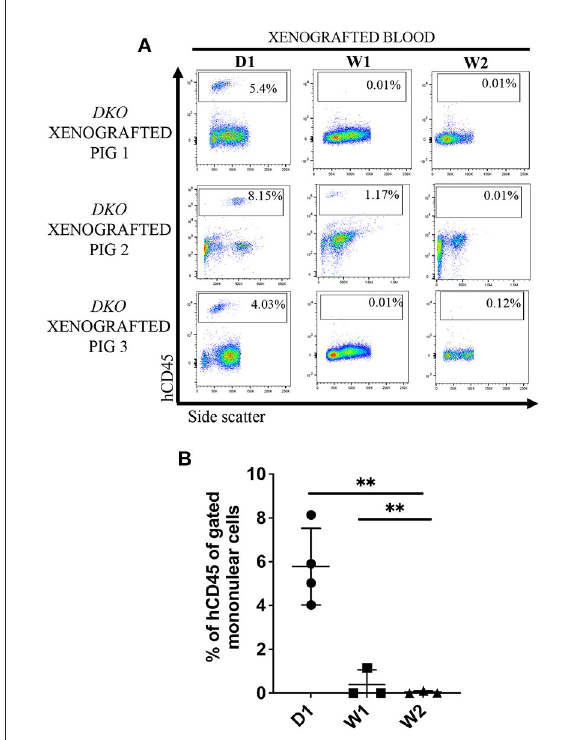
FIGURE7 Postnatal clearance of human cells from the peripheral circulation in DKO xenografted pigs. (A) Flow cytometry analysis of peripheral blood and bone marrow for human CD45 + cells at birth ( n = 1), 1 week ( n = 1), and 2 weeks ( n = 1) of age of three DKO xenografted pigs. While significant hCD45 cells were detectable at birth they reached nearly undetectable levels between 1 and 2 weeks of life. (B) Scatter plot showing the data presented in (A) . Data represent individual values for the percentage of human CD45 from mononuclear cells, line represents the mean, and adjusted p values are represented for Tukey’s multiple comparisons tests one-way ANOVA with a significance value of 0.05. * P <